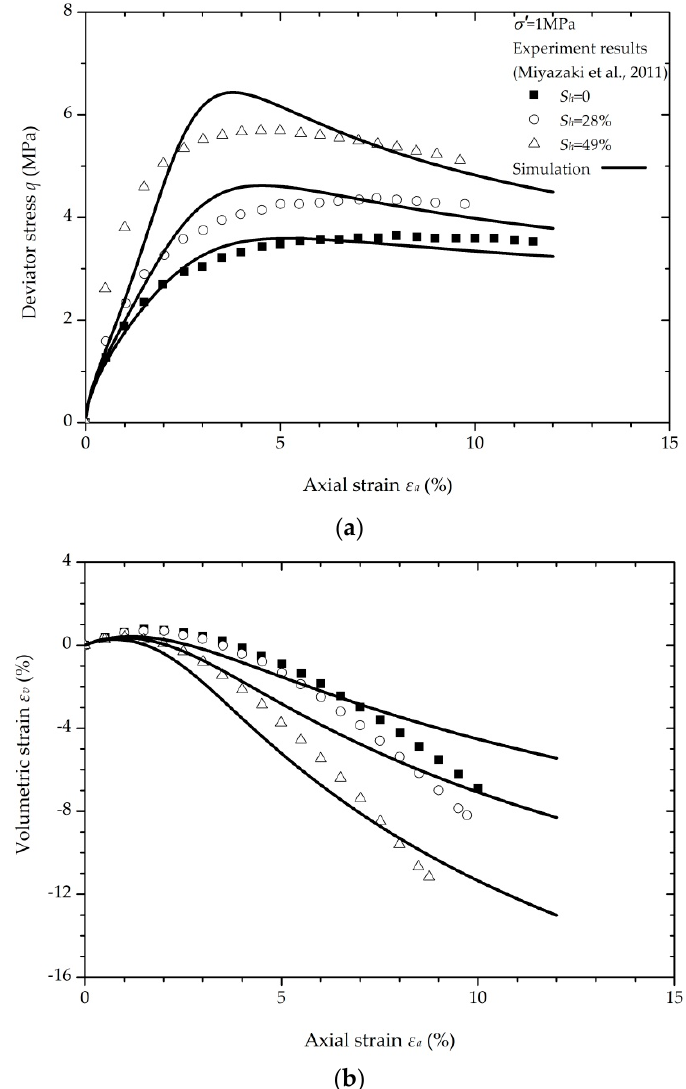
Figure 8. Comparison between the drained triaxial test results and the model predictions for MHBS synthesized from No.7 silica sand: ( a ) relationship between deviator stress q and axial strain ε a ; ( b ) relationship between volumetric strain ε v and axial strain ε a .